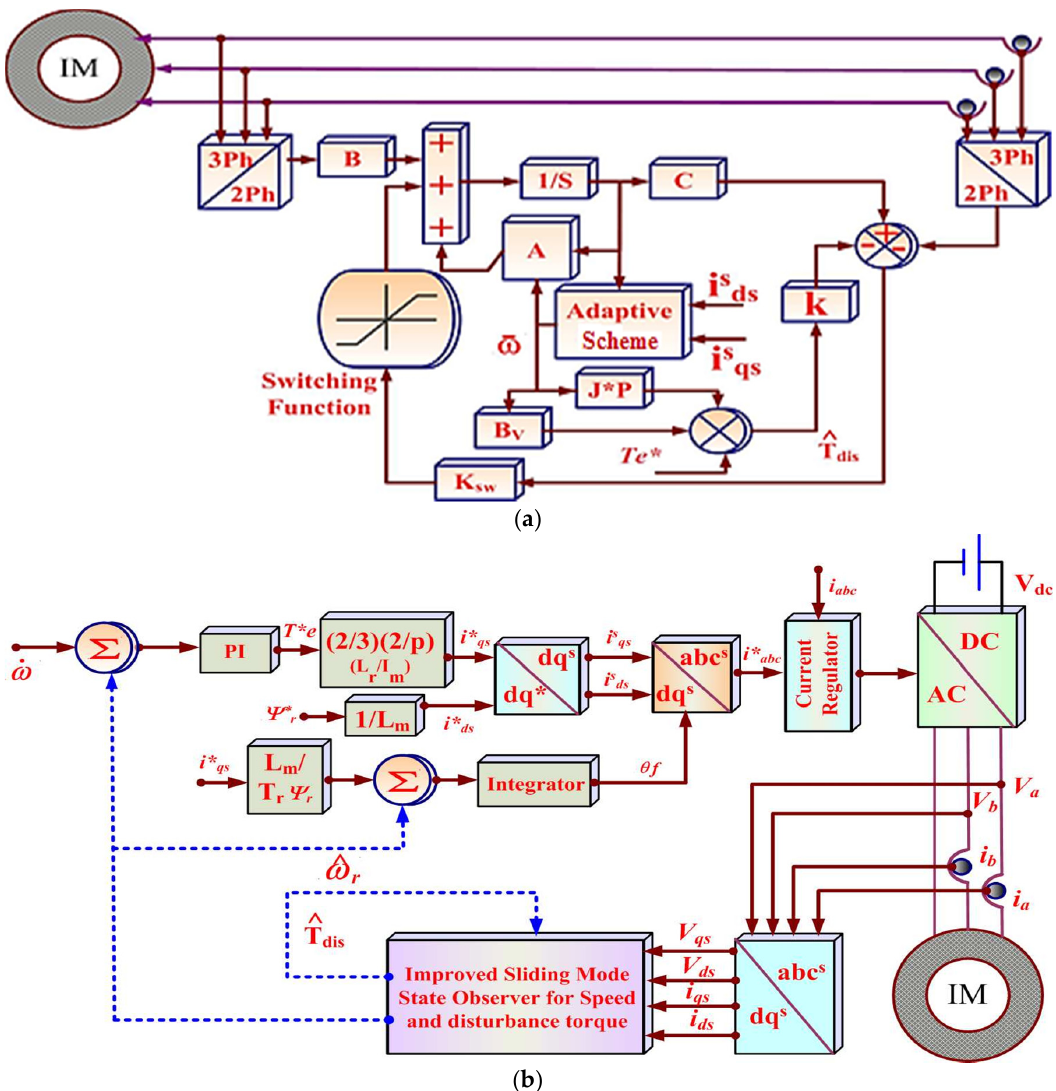
Figure 2. ( a ). Speed sensor ‐ less drive system: sliding mode speed and disturbance observer. ( b ). Schematic of the voltage source inverter fed drive system employing the improved observer.